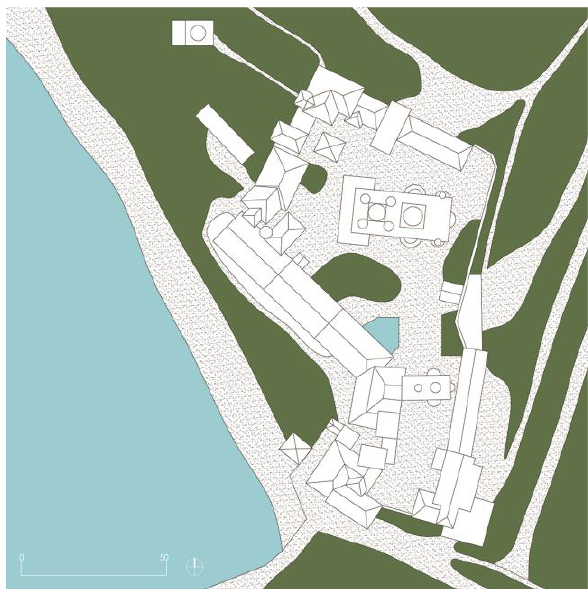
Figure 10 . The Monastery of St. Dionisio. General plan.